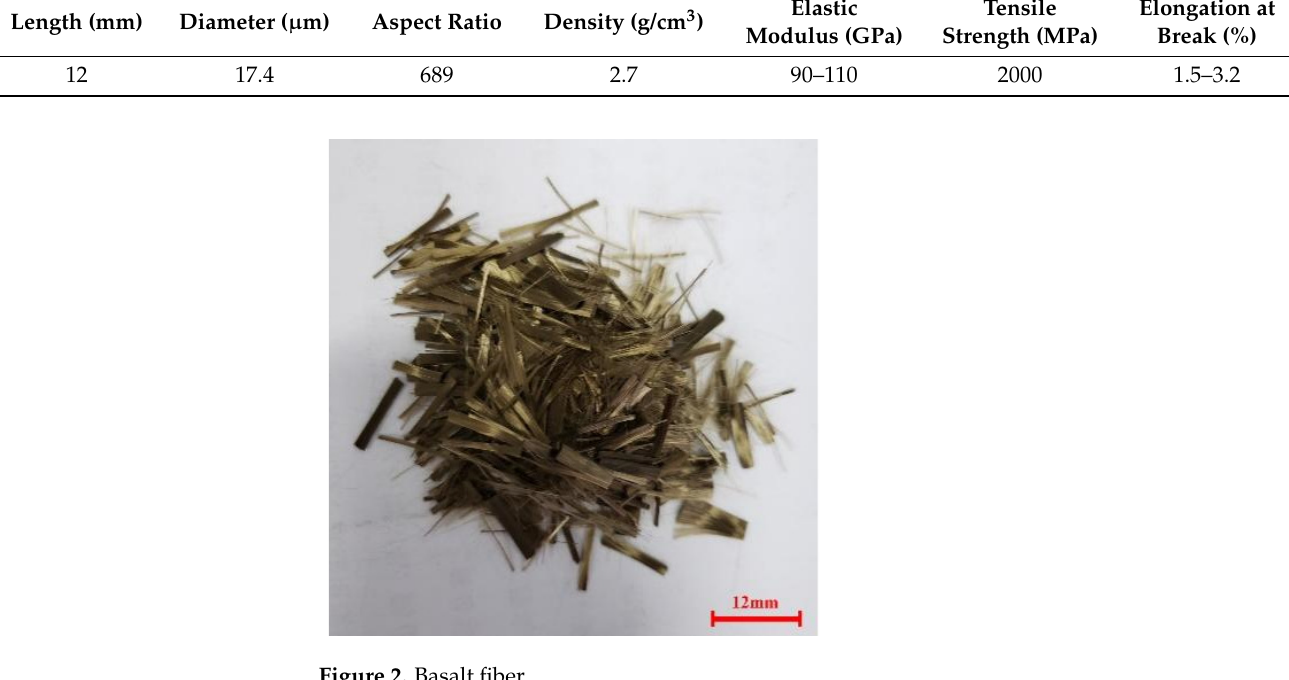
Table 2. Mix proportions of BFRPC.